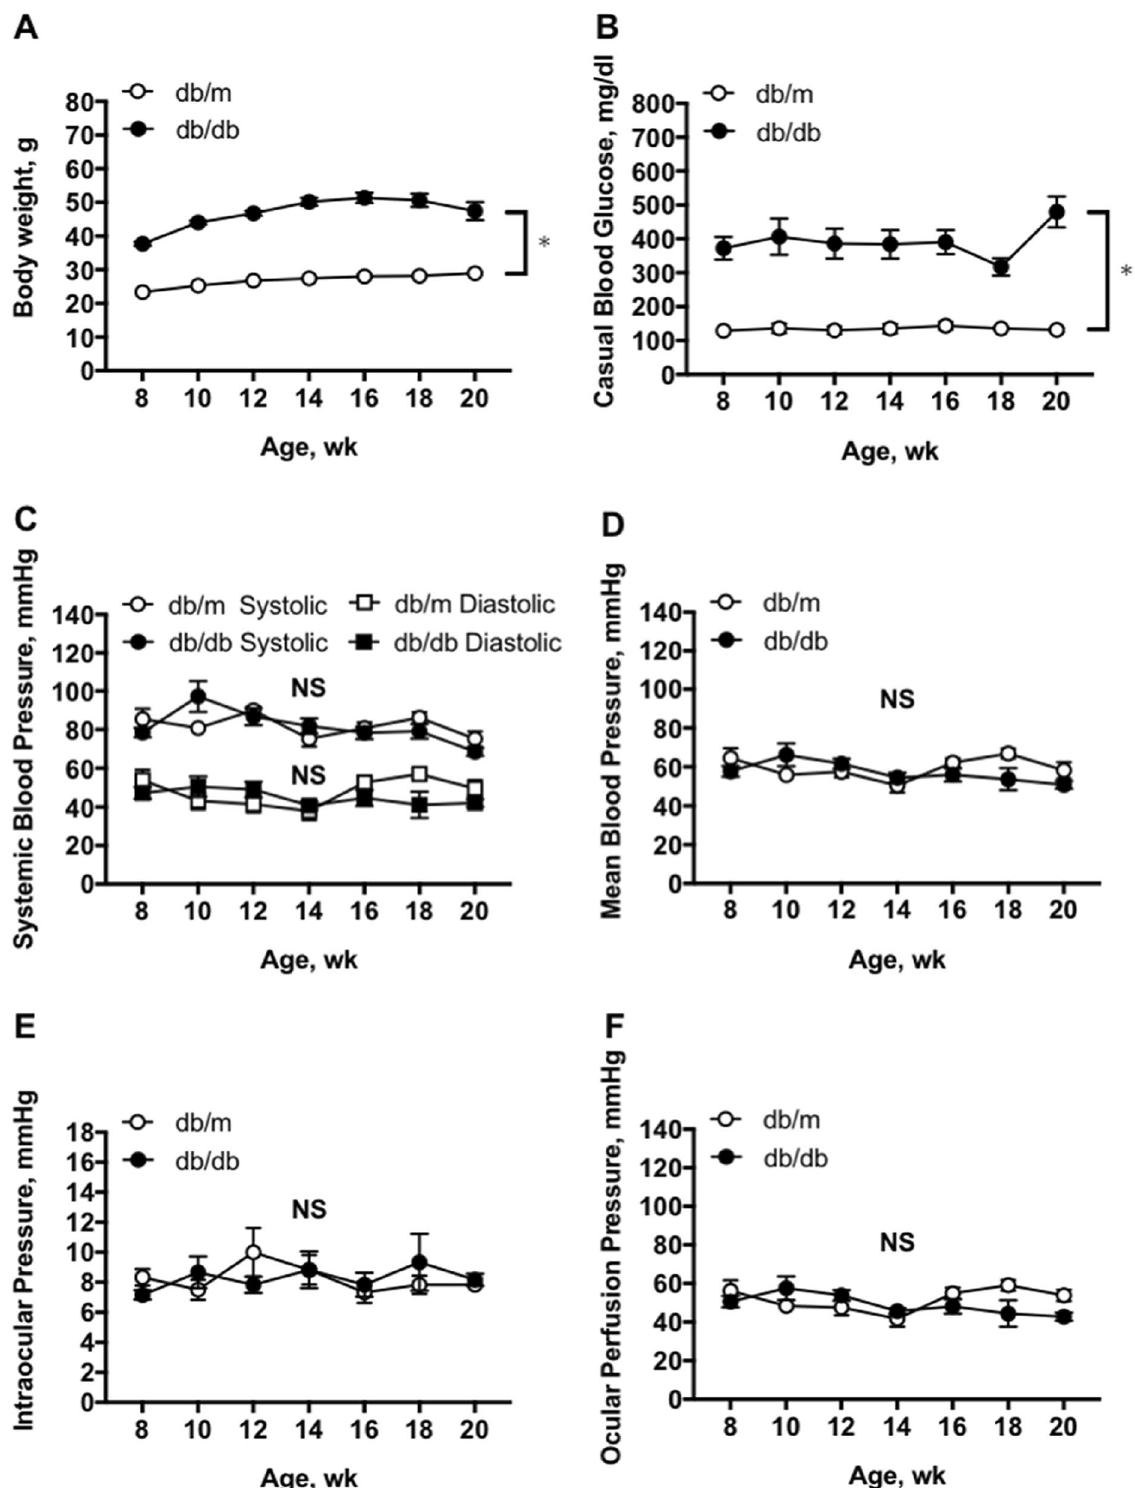
Figure 1. Average systemic and ocular parameters in db/db and db/m mice from 8 to 20 weeks of age. Significant increases were observed in body weight ( A ) and blood glucose ( B ) in db/db mice (n = 6) compared with nondiabetic db/m mice (n = 6) by two-way repeated measures ANOVA. In contrast, no significant differences were observed in systemic blood pressure ( C ), mean arterial blood pressure ( D ), intraocular pressure ( E ), and ocular perfusion pressure ( F ) between two animal groups during follow-up period. Data are expressed as the mean ± SEM; au = arbitrary unit; *P < 0.05 between groups; NS = not significant between